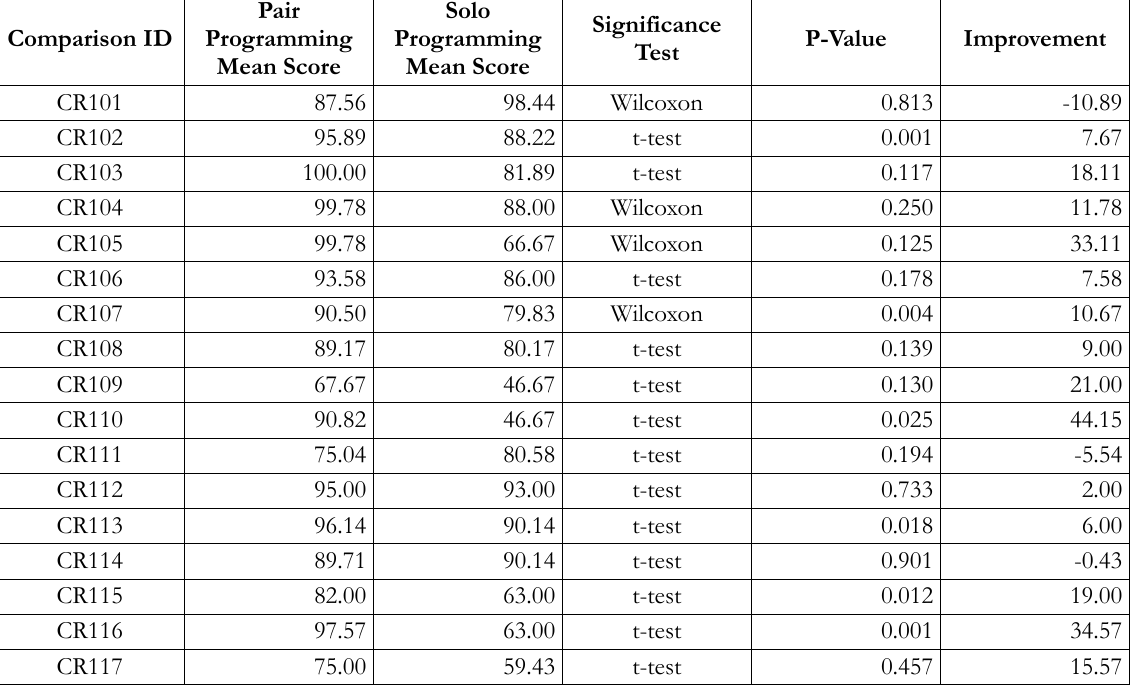
Table 5. The Improvements Gained by Utilising Pair Programming for Slow-Paced